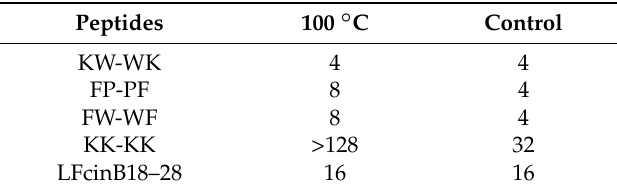
Table 4. MIC values of peptides following heating.